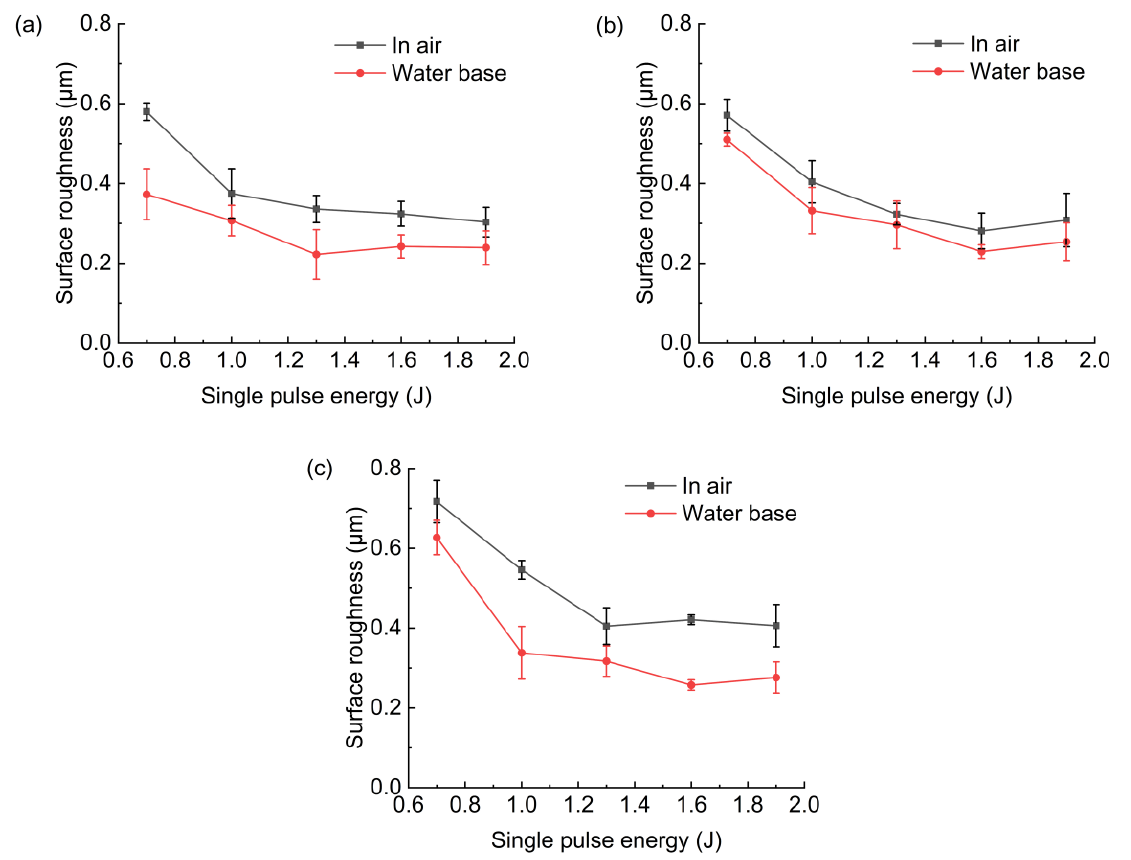
Figure 12. Effect of pulse energy on hole roughness: ( a ) hole entrance, ( b ) hole middle, ( c ) hole exit.